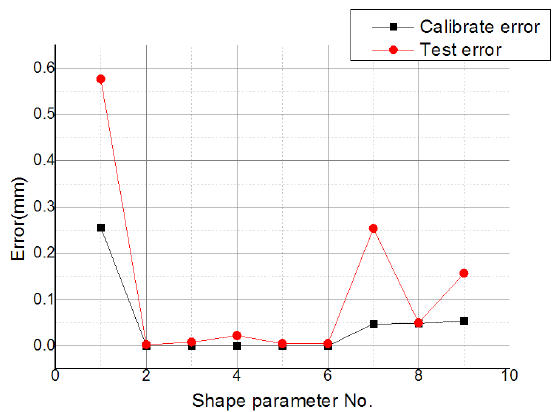
logarithmic scale.